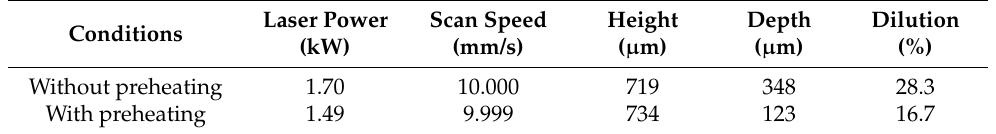
Table 5. Optimized value of the inputs and outputs for a feed rate of 15